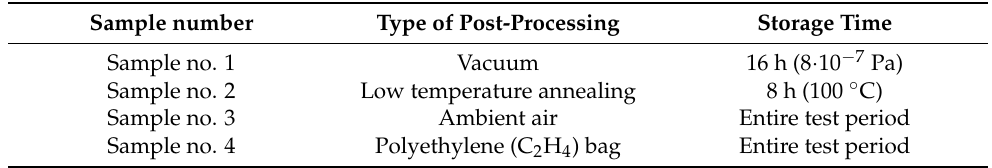
Table 3. Indication of samples and